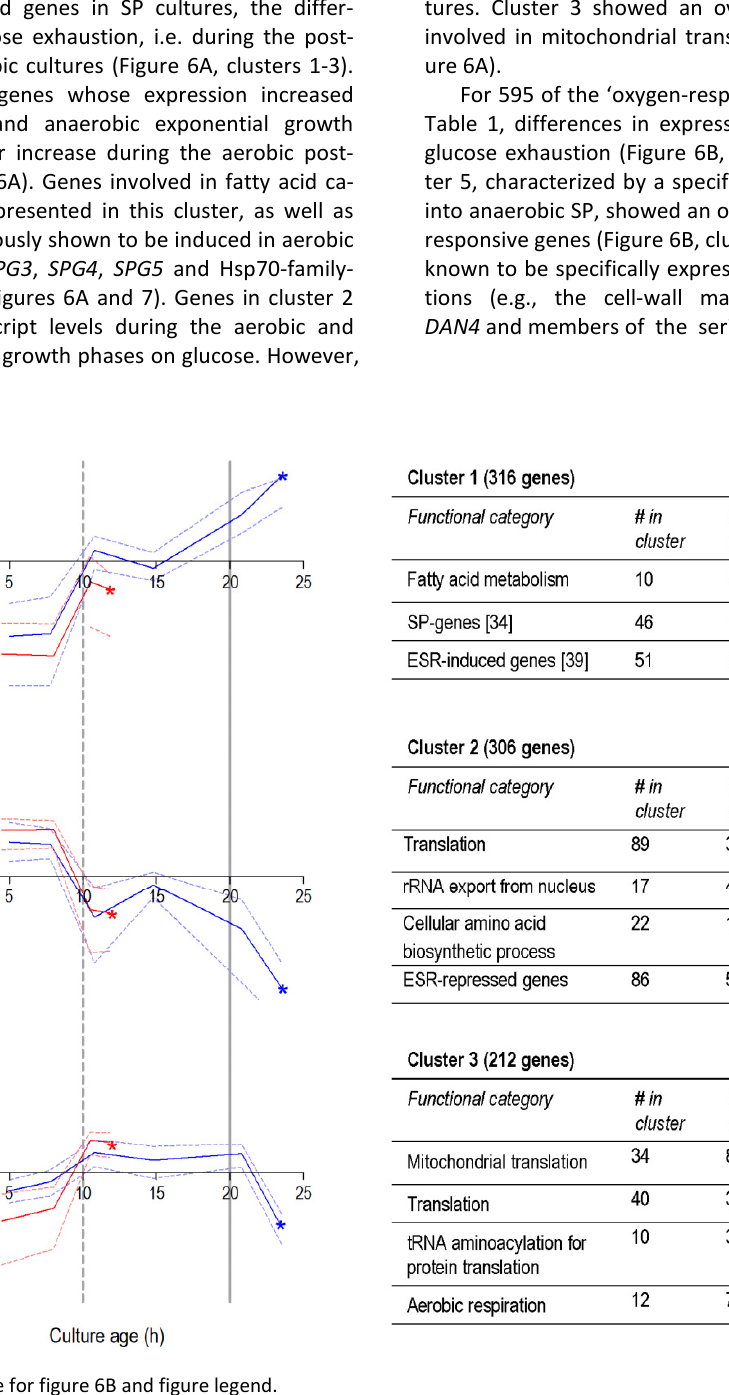
FIGURE 6A. See next page for figure 6B and figure